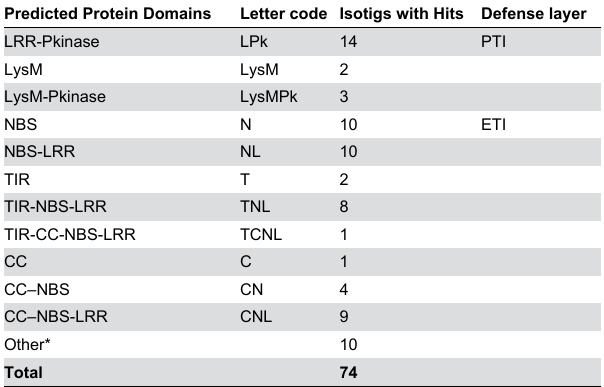
Table 3. Predicted domain architecture of resistance gene candidates in P. peruviana related to the first and second layer of